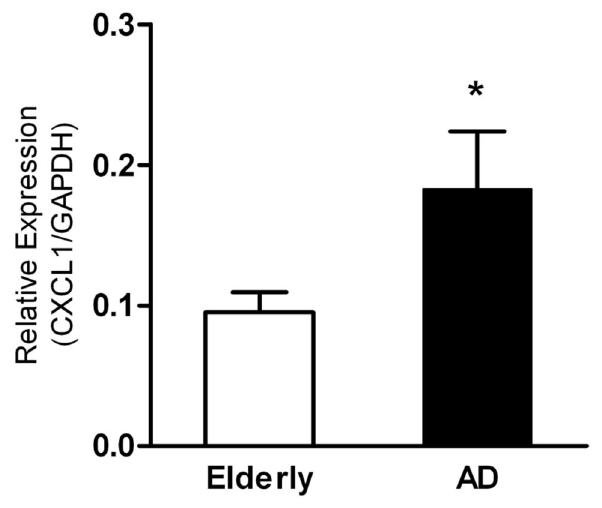
Figure 1. Monocytes derived from AD patients over- expressed CXCL1. Monocytes of 23 AD patients and 21 age- matched elderly controls were isolated and total RNA was extracted. Real-time RT-PCR was described in Material and Methods. CXCL1/GAPDH means the relative expression level of CXCL1 after correction for the expression of GAPDH.